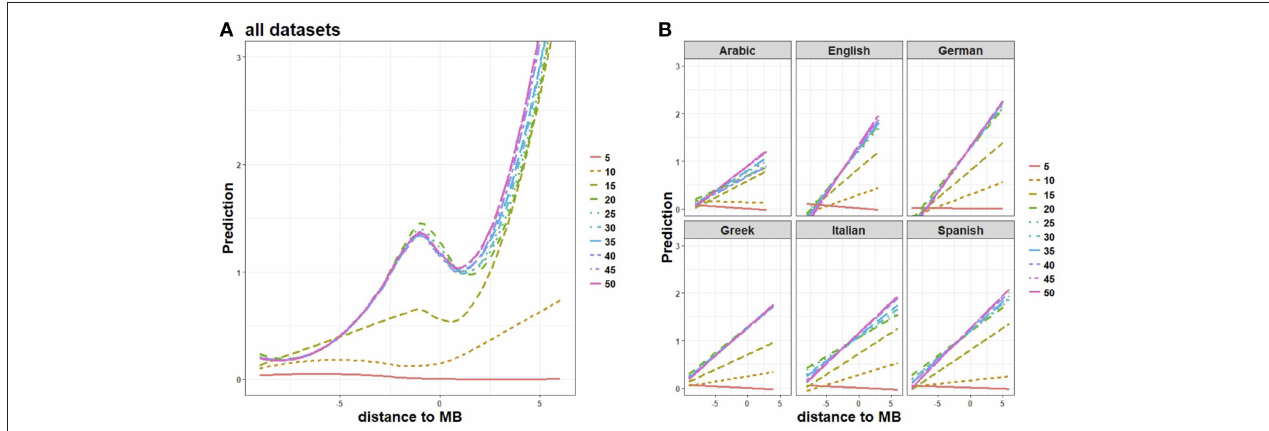
FIGURE 6 | Word structure learning: (A) overall prediction trends and (B) their language-specific linear correlates through 5-to-50 learning epochs, for different letter positions to the stem-suffix boundary ( distance to MB ). Prediction scores exhibit an increasing fit to training data, weighing up the map’s expectations across stems ( x -values < 0), and endings ( x -values ≥